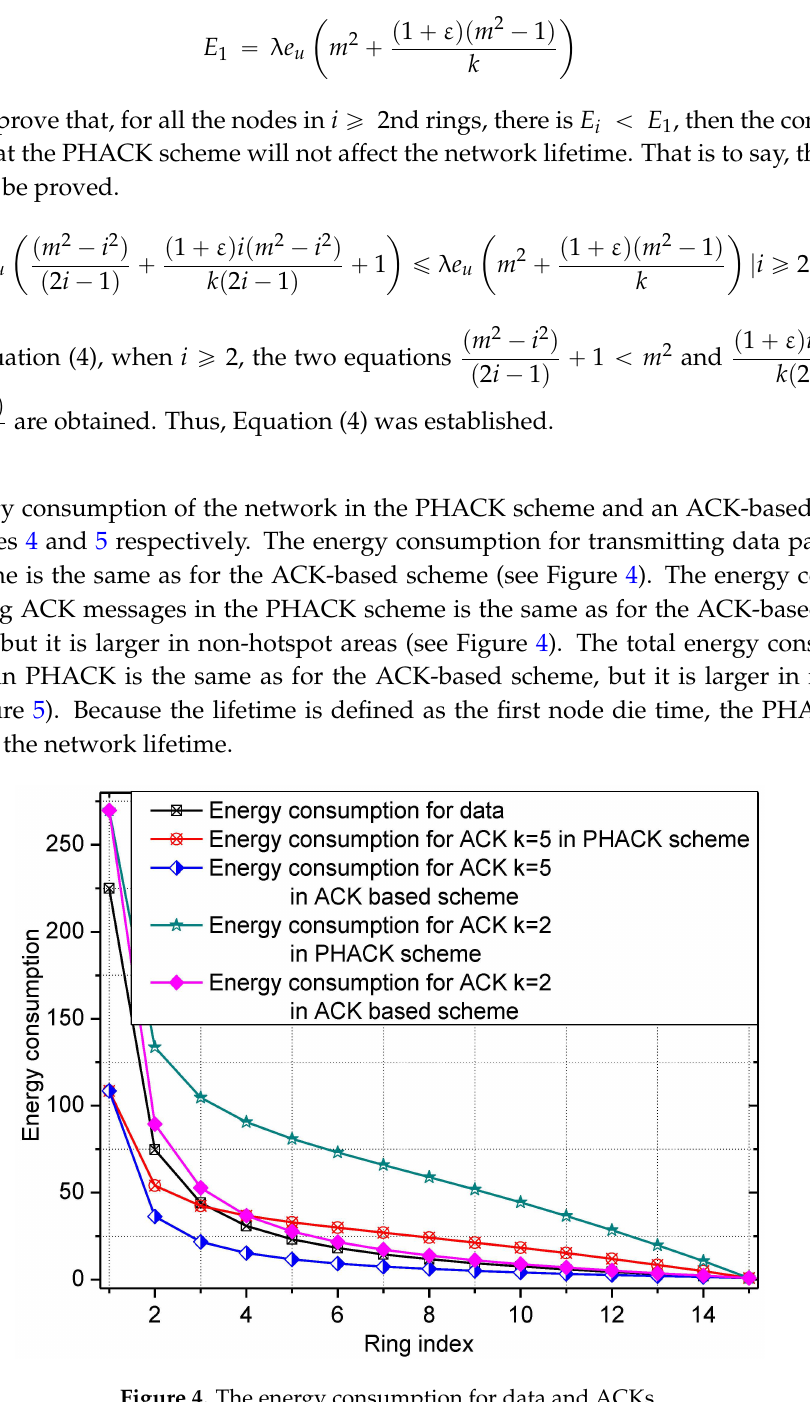
Figure 4. The energy consumption for data and